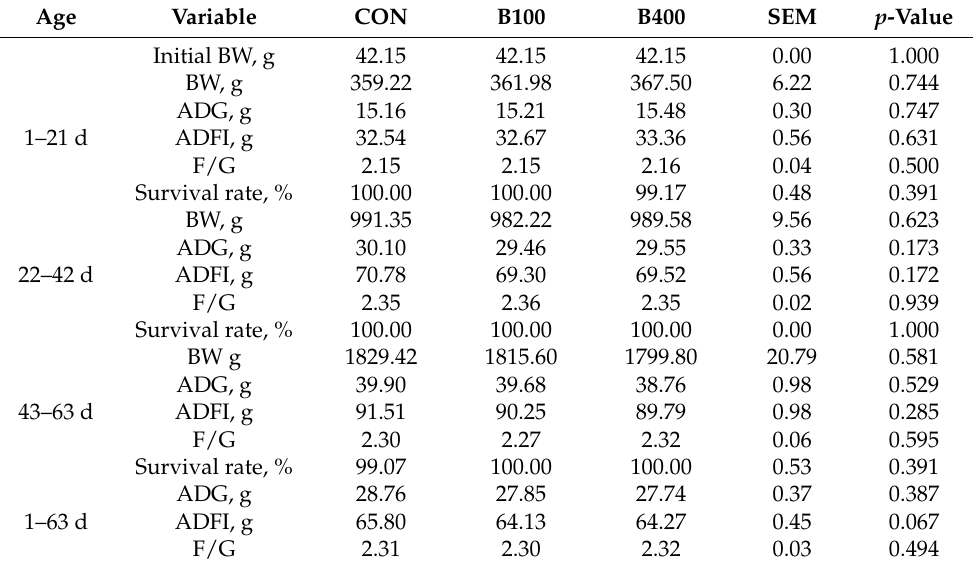
Table 2. Effects of dietary supplementation with bilberry extract on growth performance of yellow- feathered chickens 1 .